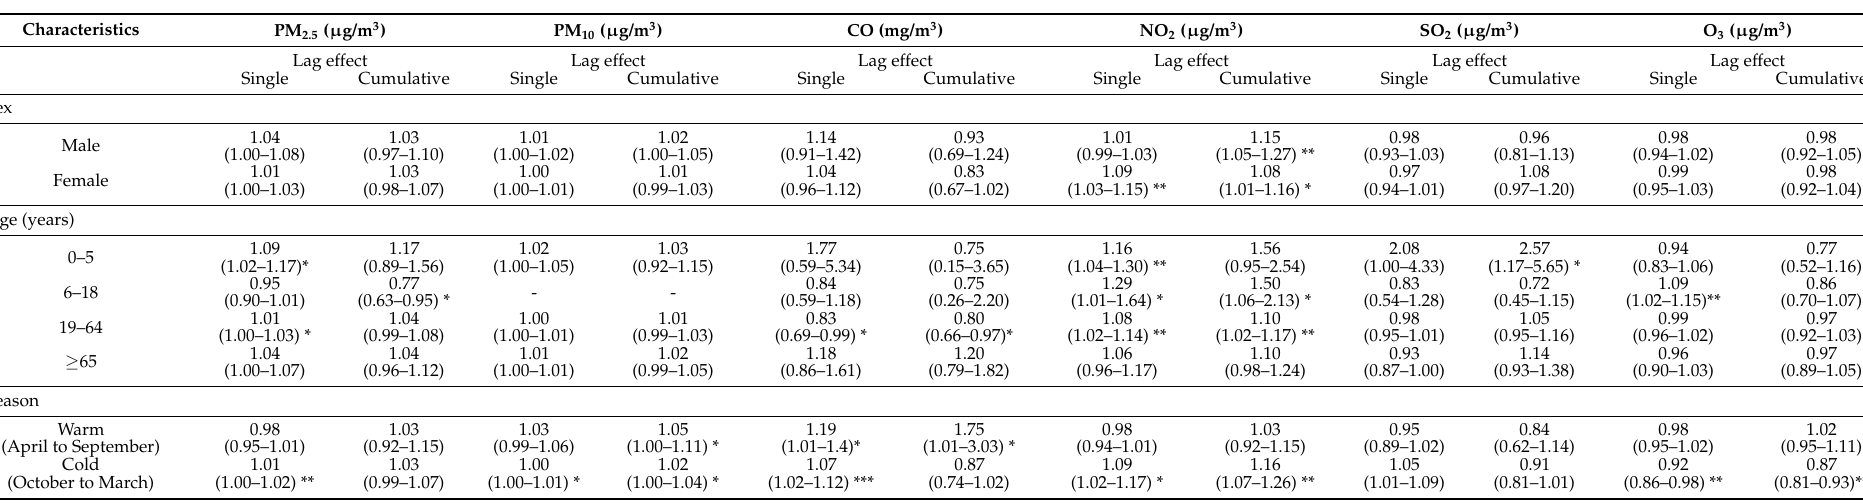
Table 4. Correlation of per 10 units increase in air pollutants and outpatients for DED, and effect modification through stratified by patients’